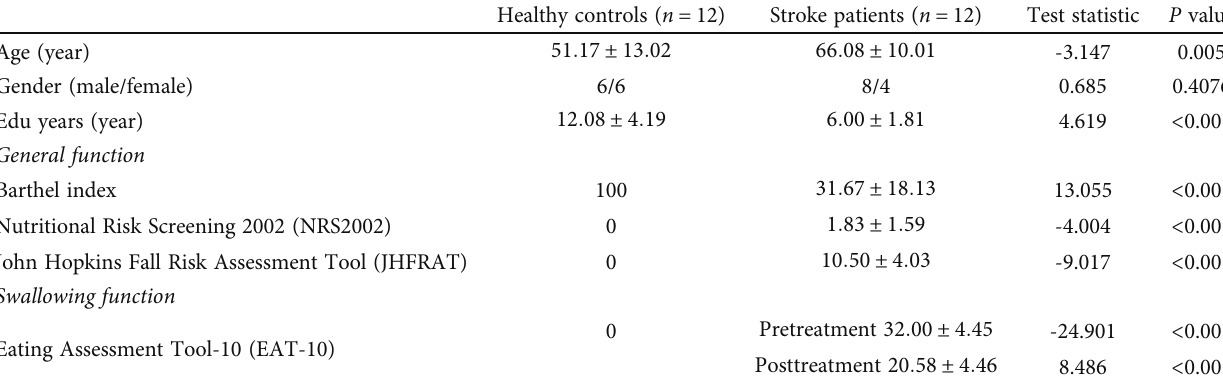
Table 2: Demographic and clinical characteristics of stroke patients and HCs.